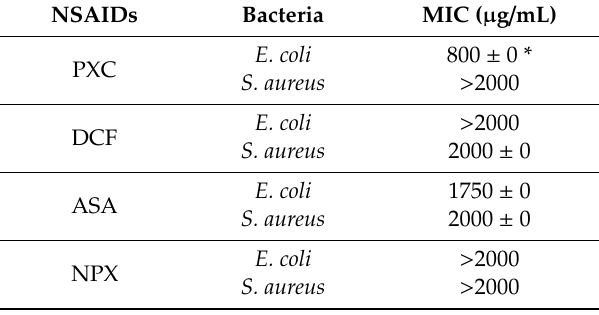
Table 1. MIC (minimum inhibitory concentration) and MBC (minimum bactericidal concentration) of PXC (piroxicam), DCF (diclofenac sodium), ASA (acetylsalicylic acid) and NPX (naproxen sodium) against E. coli CECT 343 and S. aureus CECT 976. Data are expressed as mean ± SD of three independent assays. NSAIDs